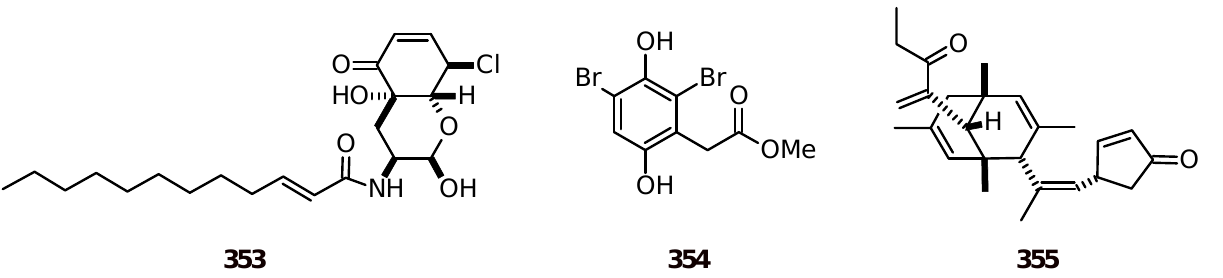
Figure 42. Structures of compounds 353 - 355 .